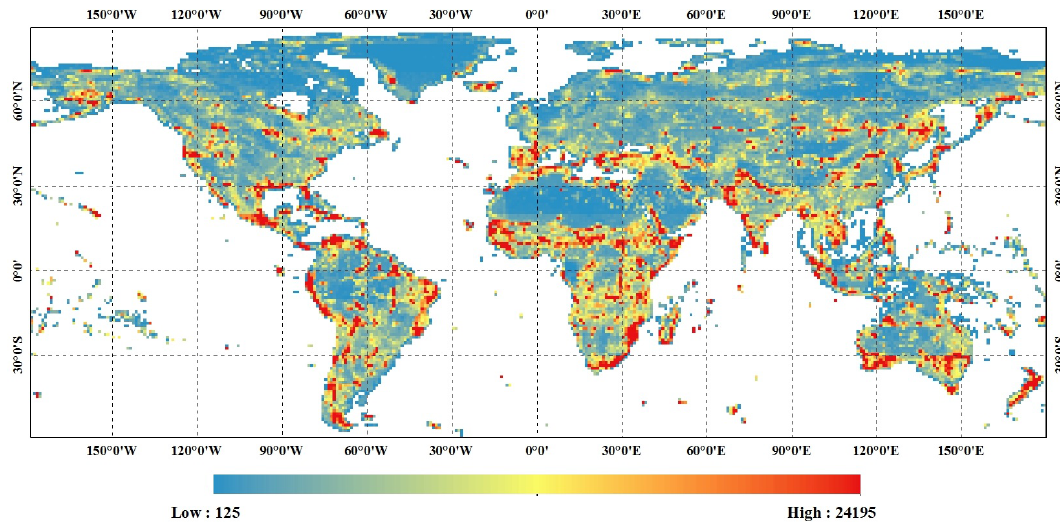
Figure 9. The number of global training samples in each 1 ◦ × 1 ◦ geographical grid cell.